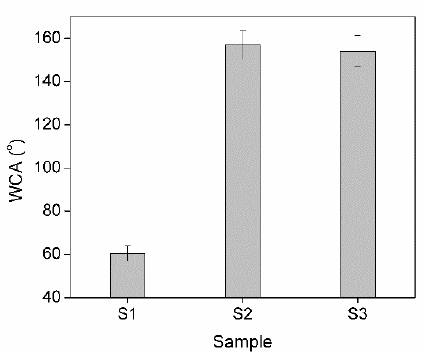
Figure 6. The water contact angle of uncoated and coated wood surfaces. Uncoated wood (S1), ZnO coated wood (S2) and epoxy@ZnO coated wood (S3).